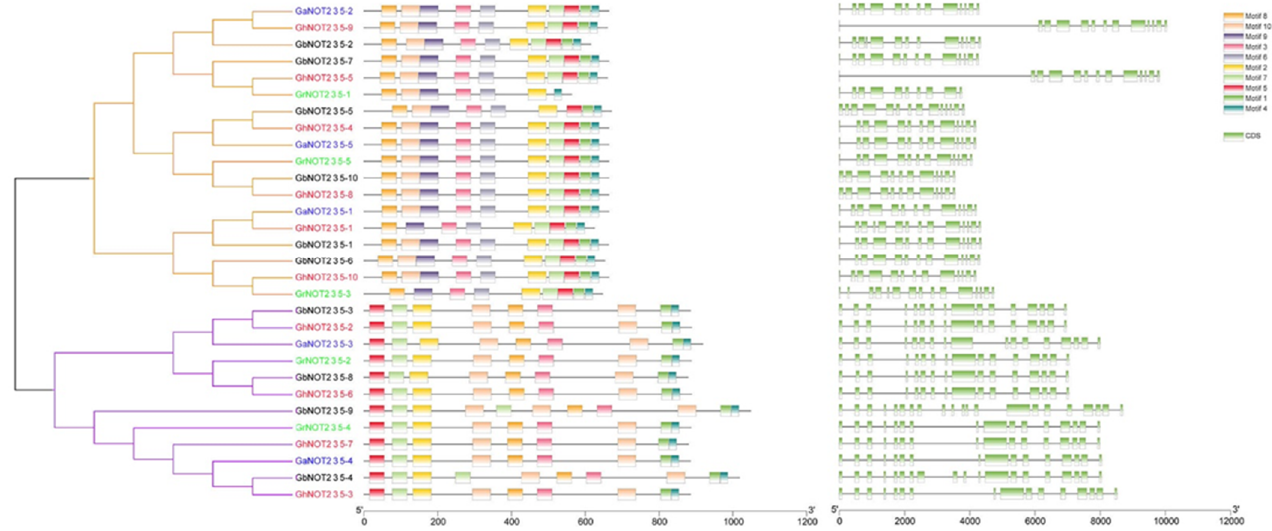
Figure 2. Analysis of conserved motif and gene structure of NOT2_3_5 domain proteins. NOT2_3_5 domain protein from G. hirsutum, G. barbadense, G. raimondii and G. arboretum were marked red, black, green and blue, respectively.